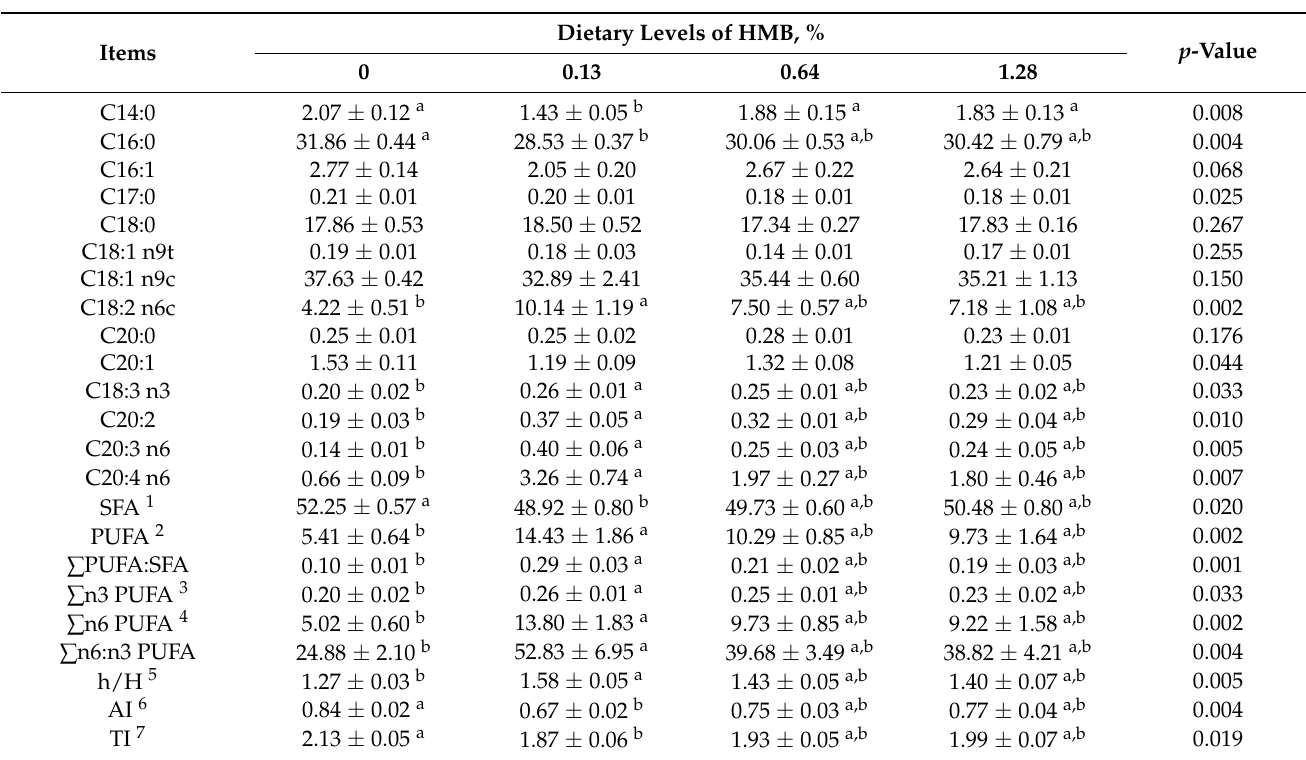
Table 4. Fatty acid composition of Longsissimus thoracis muscle in Bama Xiang mini-pigs fed the diets with various levels of HMB (% of total fatty acids) ( n =